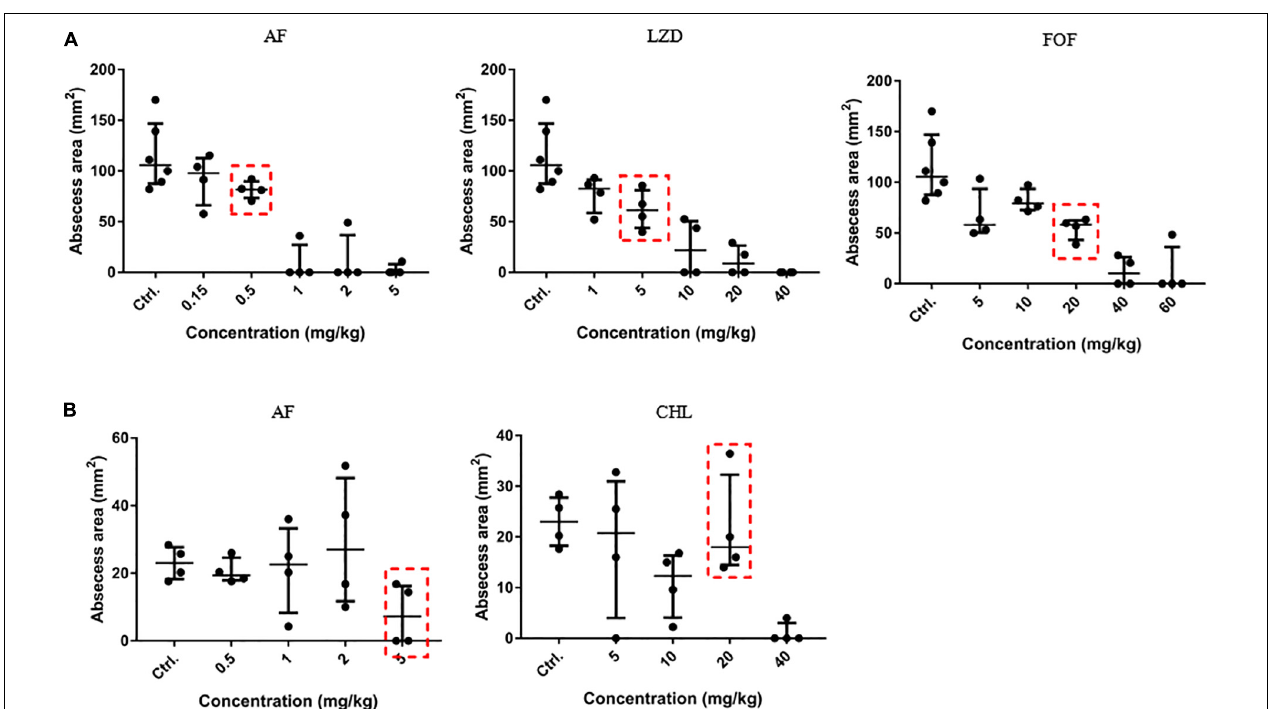
FIGURE 4 | Dose-dependent bactericidal effect of antimicrobials against cocci in vivo. (A) AF, LZD, and FOF inhibited abscess formation of S. aureus LZB1 in a dose-dependent manner (the three groups share the same control group). AF and CHL inhibited abscess formation of E. faecalis ATCC29212 (B) . The abscess model was performed by subcutaneous injection of S. aureus LZB1 (1 × 10 8 CFU/mouse), and E. faecalis ATCC29212 (1 × 10 9 CFU/mouse). One hour later, 100 µ L antimicrobials at the designated concentrations were directly subcutaneously injected. The abscess size was observed after 2